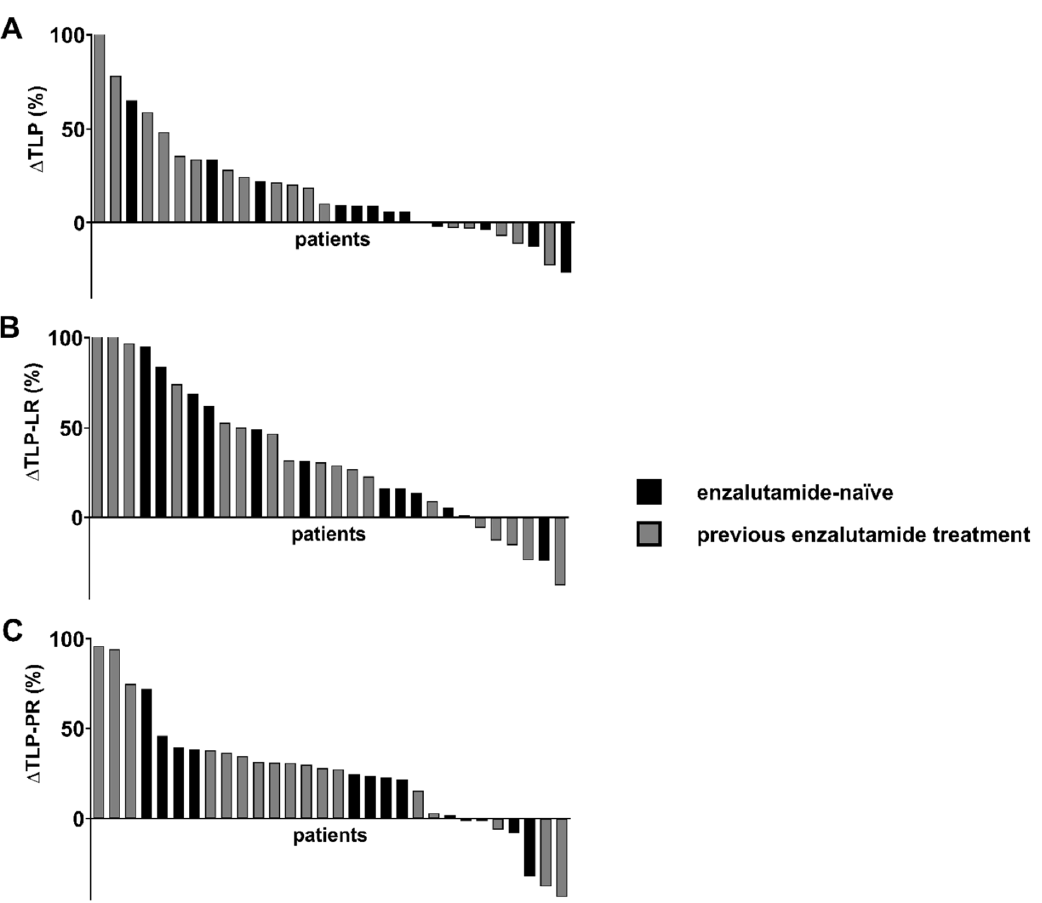
Figure 5. Waterfall plots of individual relative changes in ( A ) non-normalized total lesion PSMA (TLP), ( B ) liver-normalized TLP (TLP-LR) and ( C ) parotid-normalized TLP (TLP-PR) after medication with enzalutamide. Black—enzalutamide-naïve patients. Grey—patients with previous enzalutamide treatment. Values over 100% were cropped for simplification.